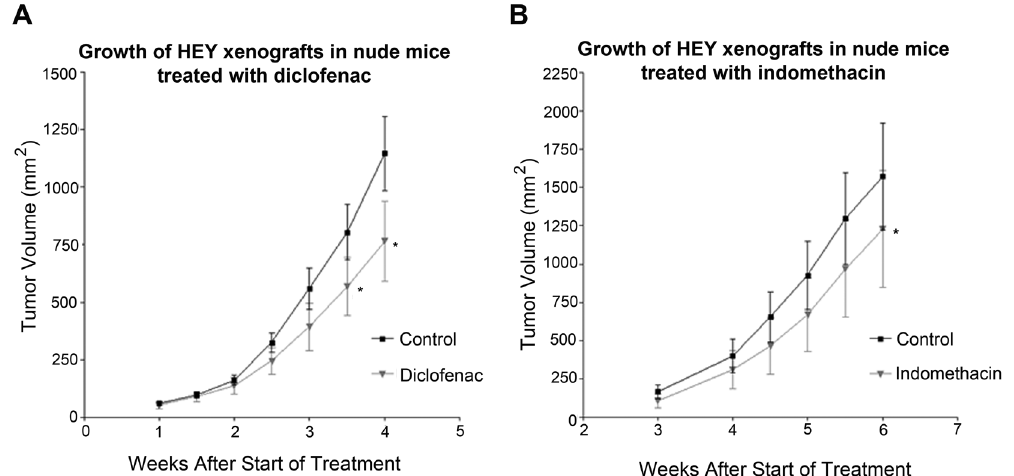
Figure 3. NSAIDs reduce the growth of HEY xenografts in nude mice. HEY cells (1.5 6 10 6 ) were injected subcutaneously into both flanks of nude mice. A) Mice were randomized into 2 groups: control or diclofenac (18 mg/kg). Treatment was started three days after cell injection and was administered intraperitoneally twice a week for 4 weeks. Tumors were measured twice a week, starting at week 1. The control group (only PBS) consisted of 6 mice that developed 12 tumors in total; the diclofenac group (18 mg/kg) consisted of 6 mice that developed a total of 11 tumors. Values represent means 6 standard errors. Statistical significance is represented as * p , 0.05. B) Mice were randomized into 2 groups: control or indomethacin (2.5 mg/kg). Treatment was started the day after cell injection and was given daily in drinking water for 6 weeks. Tumors were measured twice a week, starting at week 3. The control group (only water) consisted of 5 mice that developed 9 tumors in total; the indomethacin group (2.5 mg/kg) consisted of 5 mice that developed a total of 5 tumors. Values represent means 6 standard errors. Statistical significance is represented as * p , 0.05.